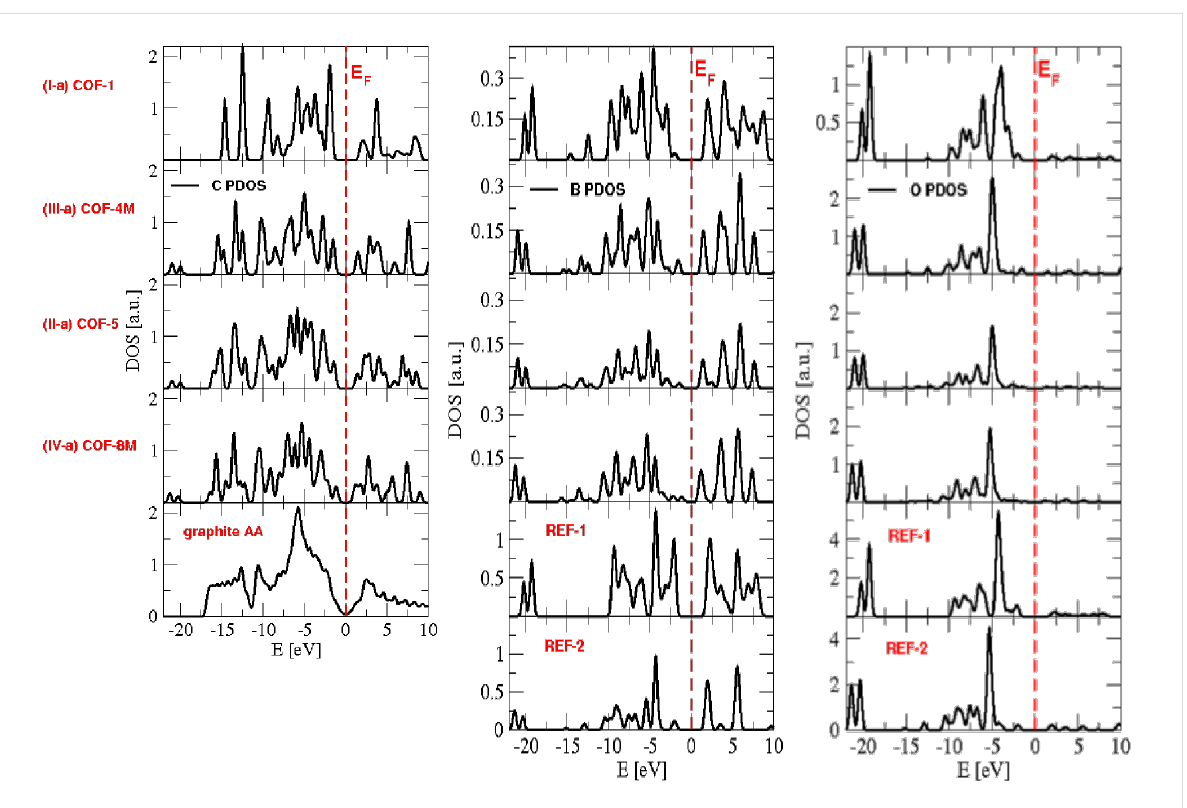
Figure 8: Partial density of states of carbon (left), boron (center), and oxygen (right) atoms of COFs built from type- a linkers. The vertical dashed line in each figure indicates the Fermi level E F